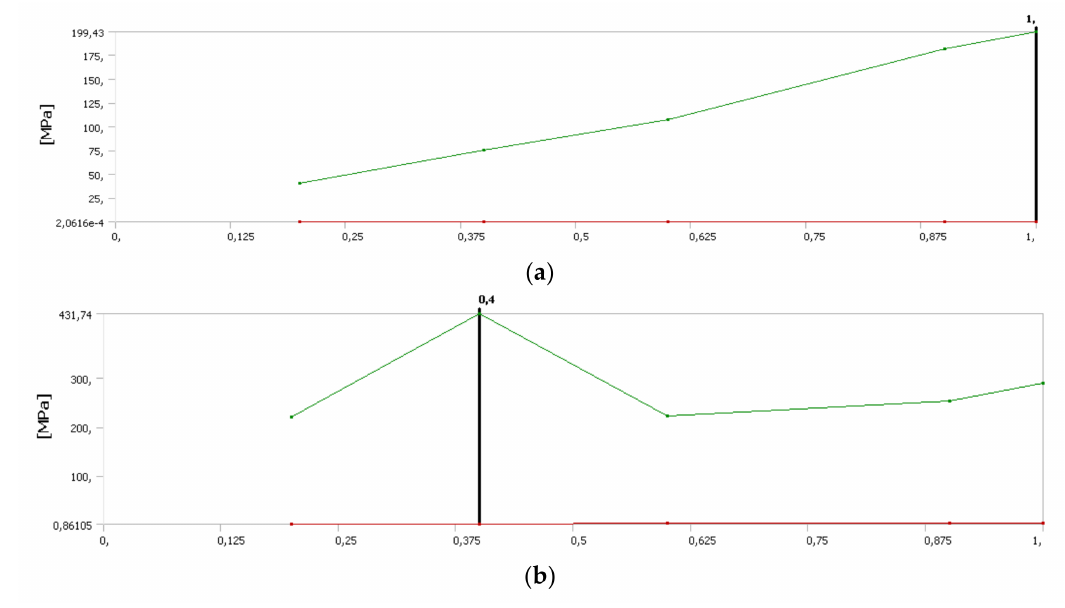
Figure 7. Tension diagrams depending on load steps: ( a ) nut; ( b )